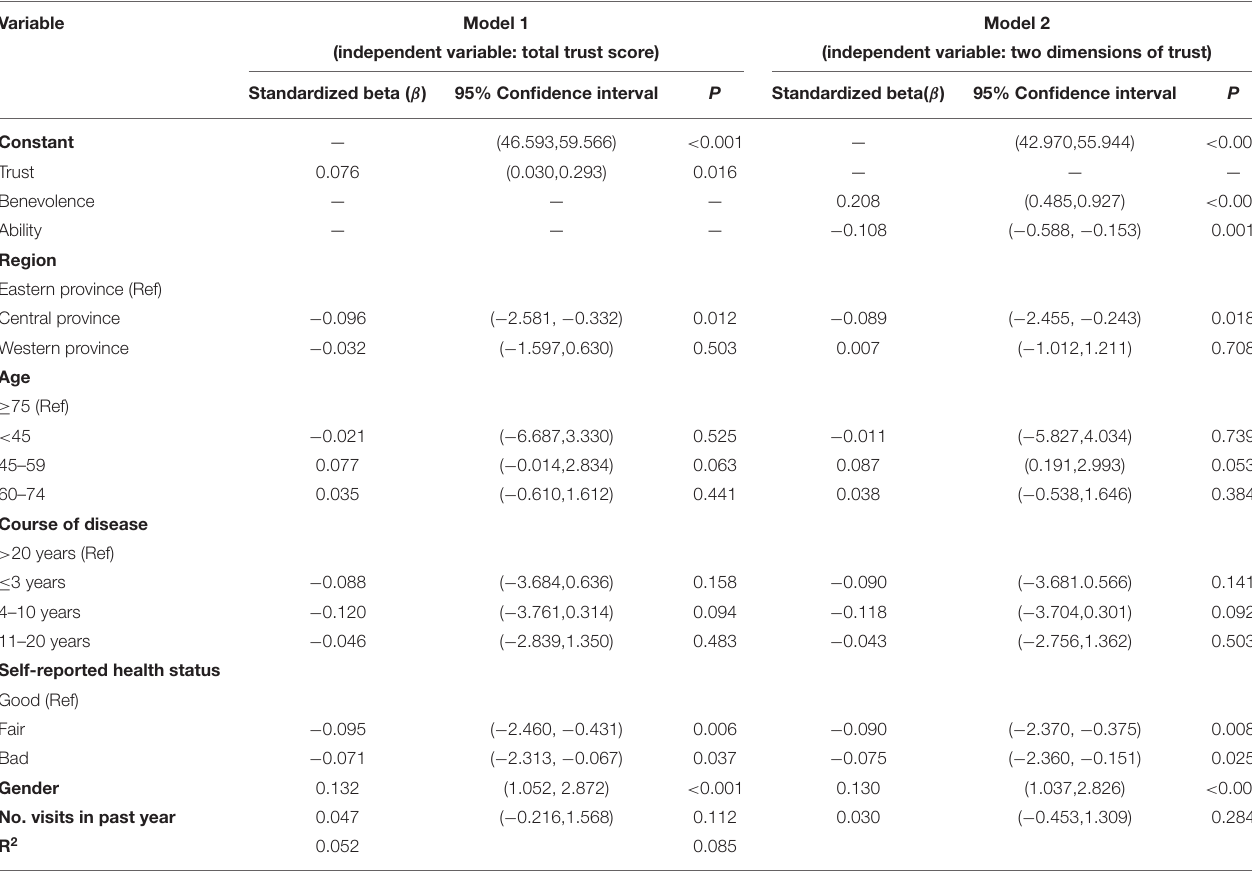
TABLE 4 | Results of linear regression models examining predictors of hypertensive patients’ treatment adherence with PCPs.